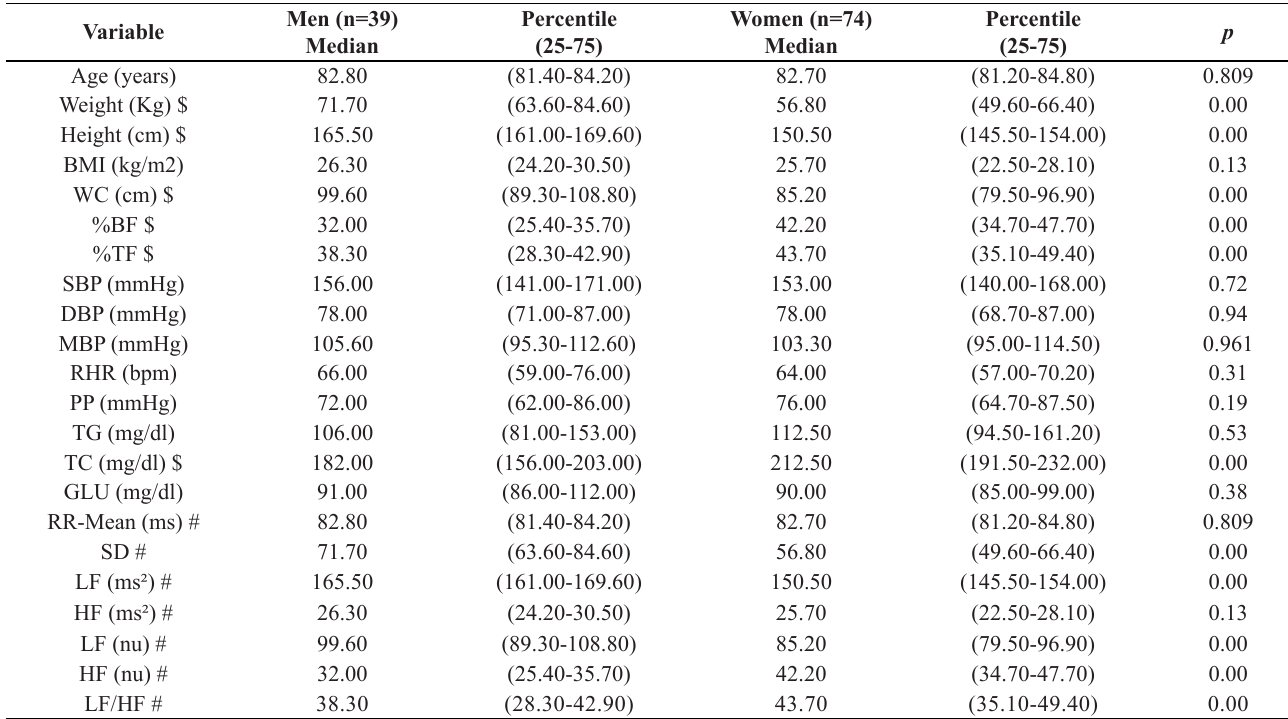
Table 1. Comparison of variables in relation to anthropometric, metabolic, hemodynamic and heart rate variability according to gender in the elderly aged 80 years old and